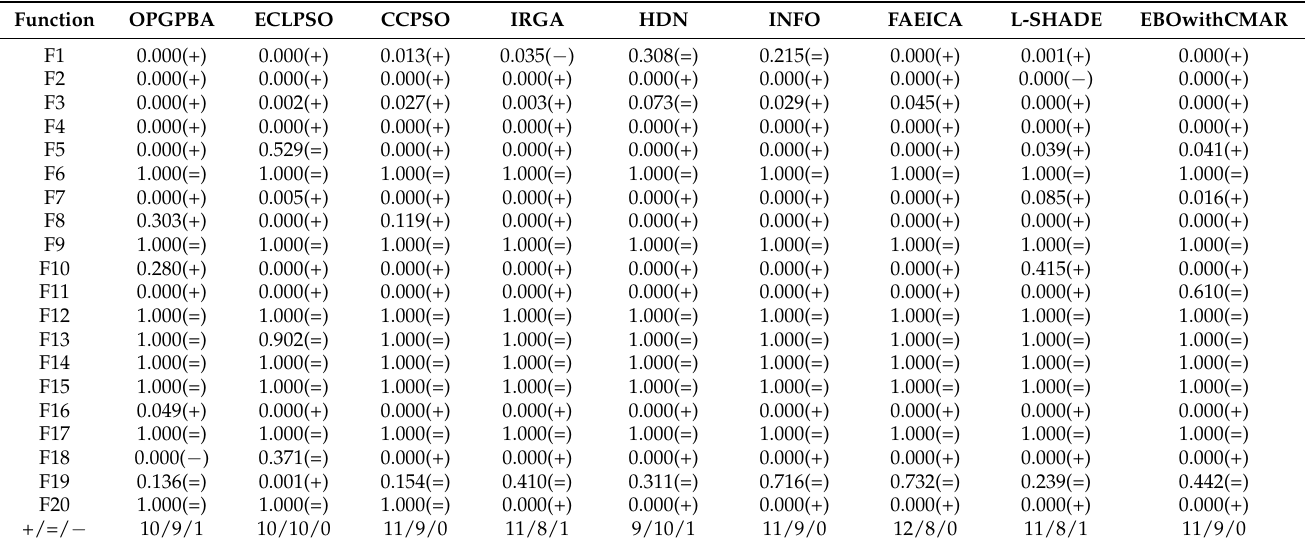
Table 10. Wilcoxon signed rank test results ( p -values) of classical test problem analysis.